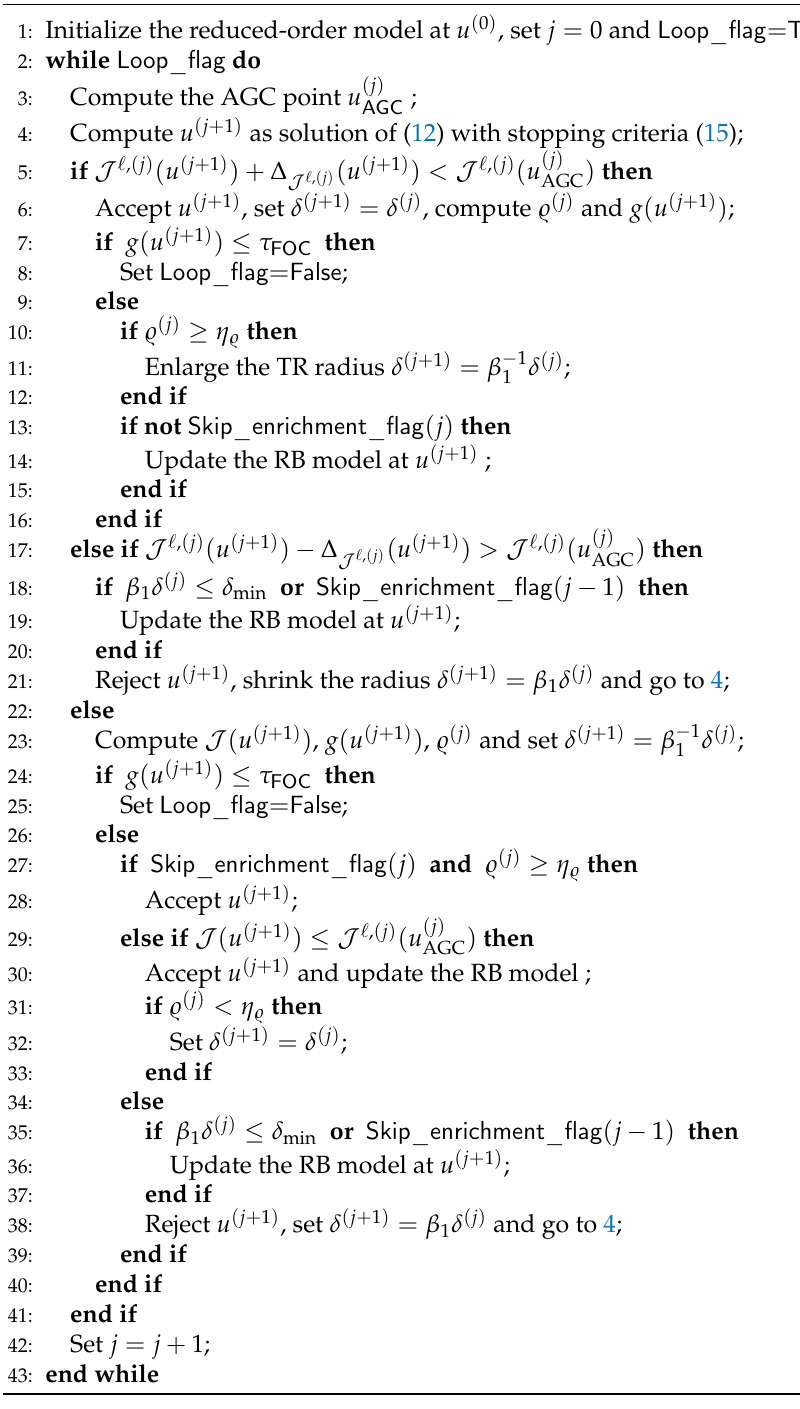
Algorithm 2 TR-RB